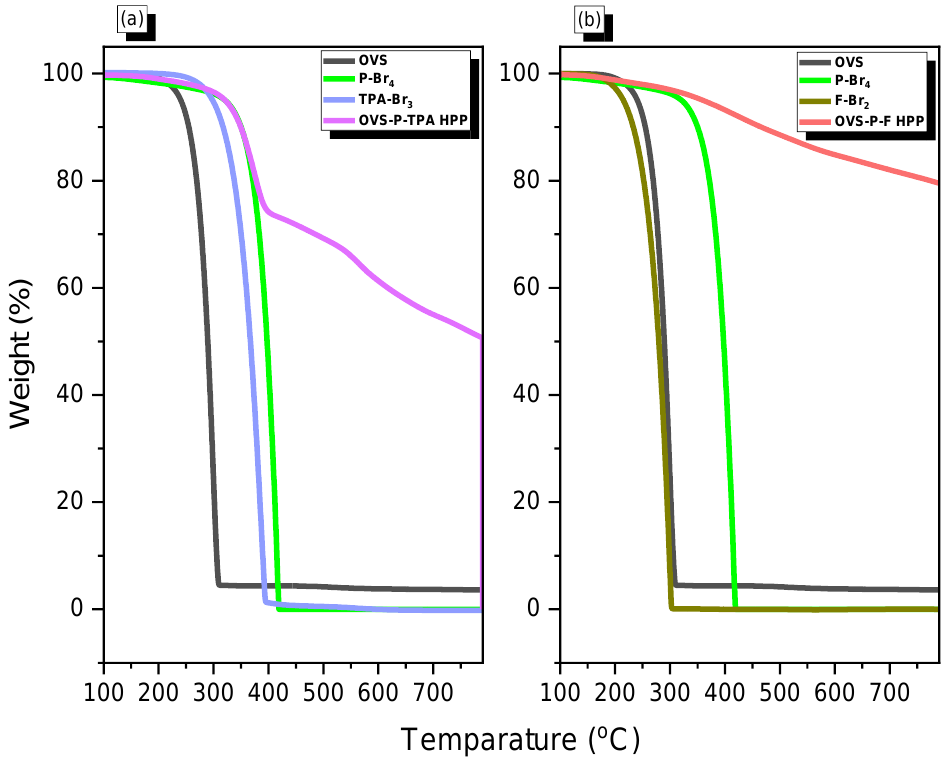
Figure 3. TGA analyses of ( a ) OVS, P-Br 4 , TPA-Br 3 , and OVS-P-TPA HPP and ( b ) OVS, P-Br 4 , F-Br 2 , and OVS-P-F HPP under N 2 . Table 1. TGA, BET, and capacitance data for the OVS-HPPs